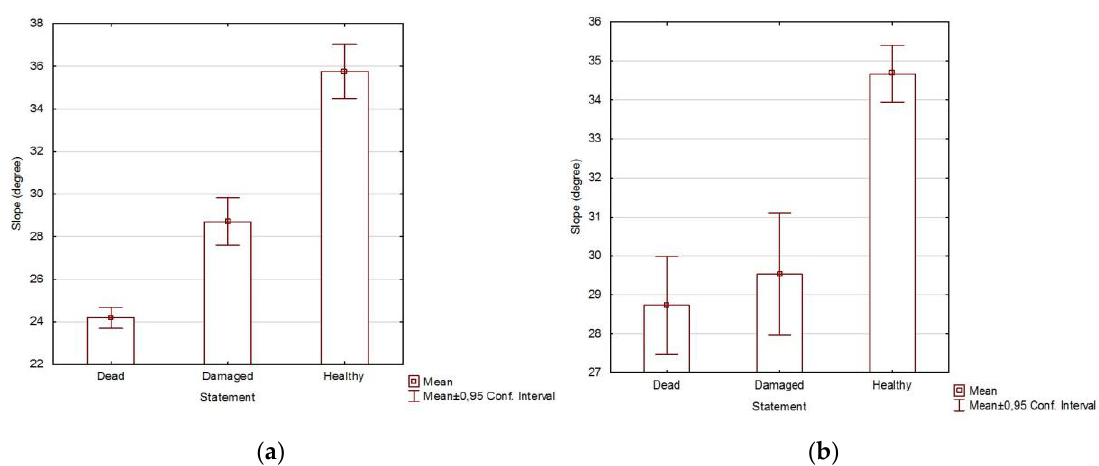
Figure 11. Relation of the slope of terrain and health status of trees in Jabal Samhan population ( a ) and Jabal al Qamar/Qara population ( b ).